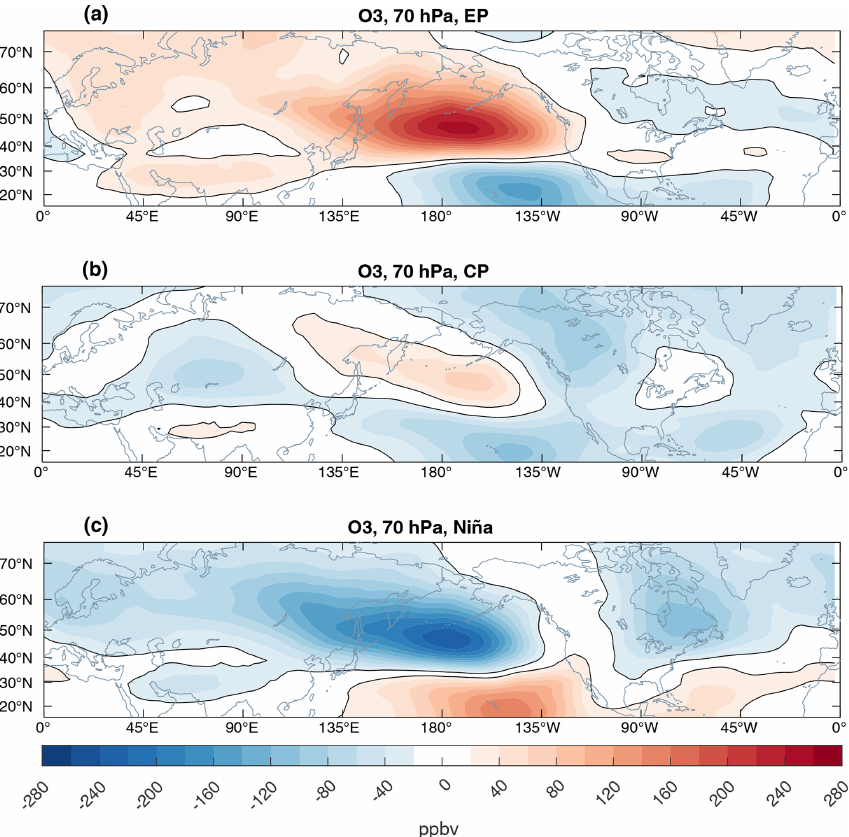
Figure 8. January–March composites of anomalies in the ozone mixing ratio at the 70hPa level pressure for (a) EP El Niño, (b) CP El Niño and (c) La